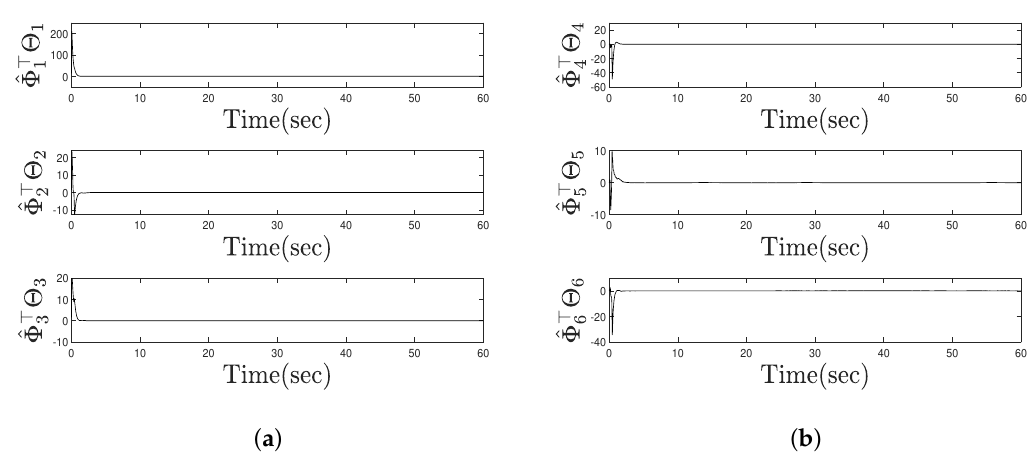
Figure 6. Outputs of radial basis function neural networks of the proposed approach for Scenario 1 ( a ) Φ 1 Θ 1 , Φ 2 Θ 2 , and Φ Θ Φ Θ Φ Θ Φ Θ 3 3 ( b ) 5 5 , and 6 6 . 4 4 ,